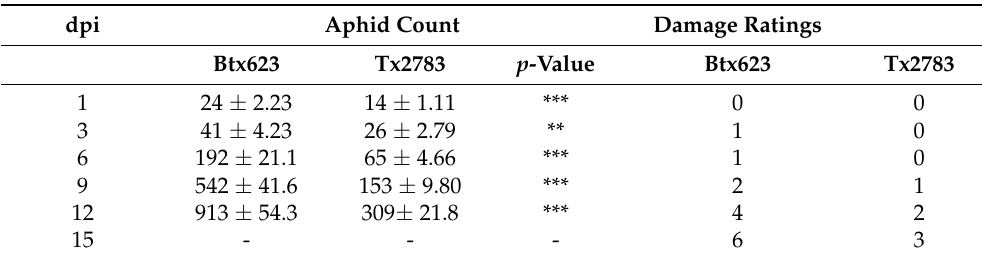
Table 1. Aphid count and damage ratings data for two sorghum genotypes subjected to SCA infestation. dpi Aphid